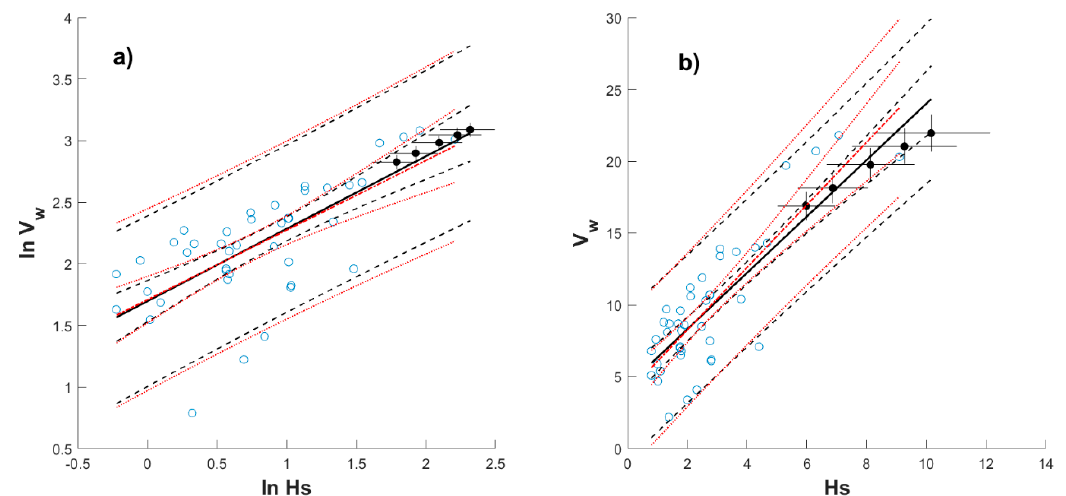
Figure 10. Regression lines and confidence intervals including (solid and dashed lines, respectively) and excluding (dashed–dotted and dotted lines, respectively) T -yr values for February; ( a ) and ( b ) for logarithmic space and linear space, respectively. Filled circles represent T -yr values with embedded perpendicular lines indicating confidence intervals from GEV models.